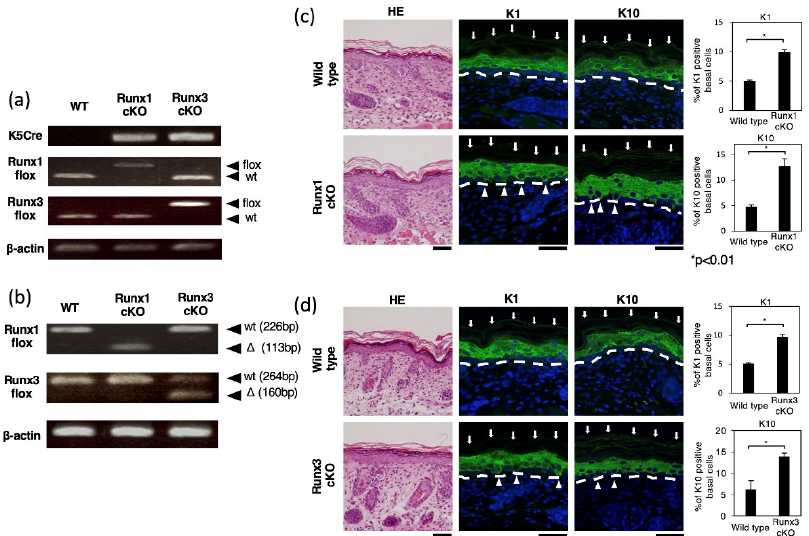
Figure 5. Effects of Runx1/Runx3 knockout on keratin 1 and keratin 10 expression in keratinocytes. ( a ) Genotyping of the skin-specific Runx1 or Runx3 knockout mice. Genomic DNA was isolated from the tails of K5Cre-Runx1fl/fl mice, K5Cre-Runx3 fl/fl mice, and wild-type mice and processed for PCR. The alleles detected were K5-Cre transgene ( top row), Runx1 allele ( second row), Runx3 allele (third row), and β -actin ( bottom row). ( b ) RT-PCR analysis of Runx1 or Runx3 transcripts in the epidermis-